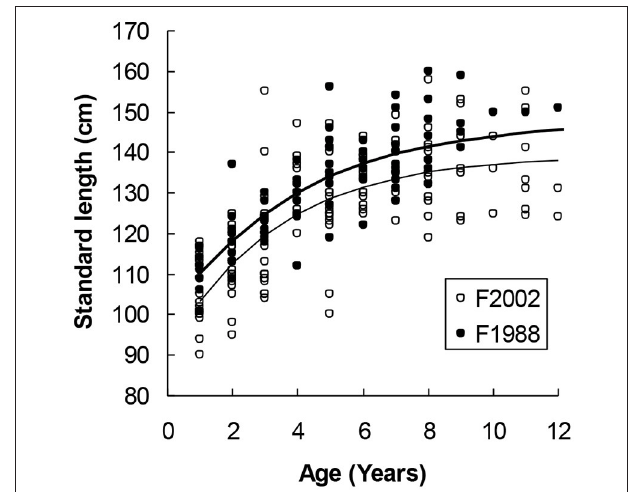
FIGURE 3 | Female harbor seals in Skagerrak followed a steeper growth curve in the sample collected in 1988 (upper curve) as compared with 2002 (lower curve). The difference in asymptotic length (7.06cm) was statistically significant ( Table 2